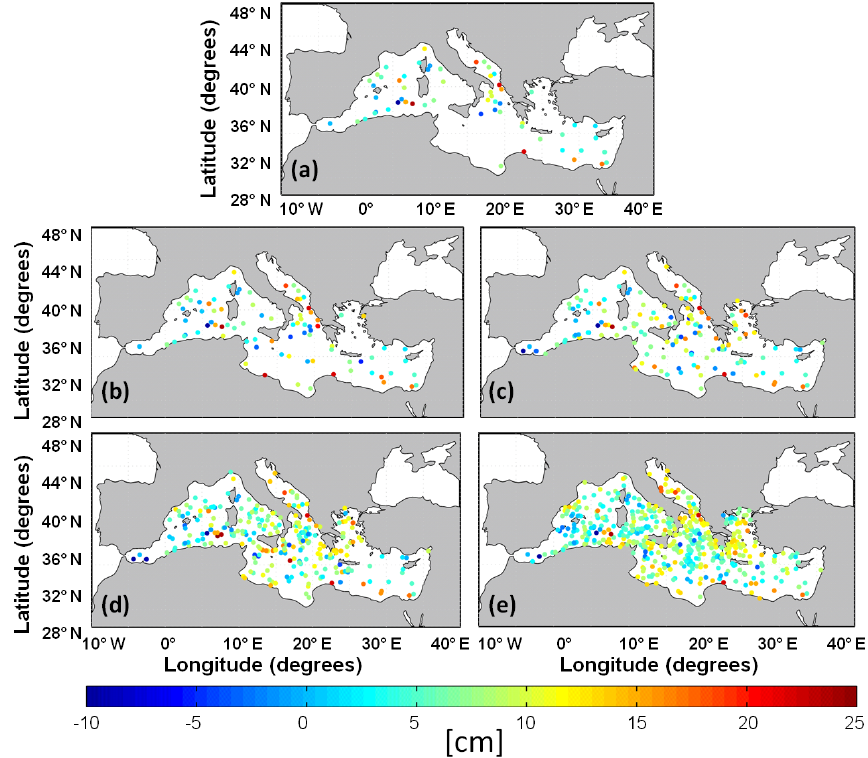
Figure 7. (a) Actual positions of the Argo array operating in the Mediterranean basin on 22 December 2014 (58 floats). Colours indicate the SLA (cm) extracted at those locations from the original altimetry map of that day. The panels (b) – (e) display the original Argo array enlarged with random virtual floats in order to simulate an Argo array configuration of 84, 150, 250 and 450 floats, respectively.